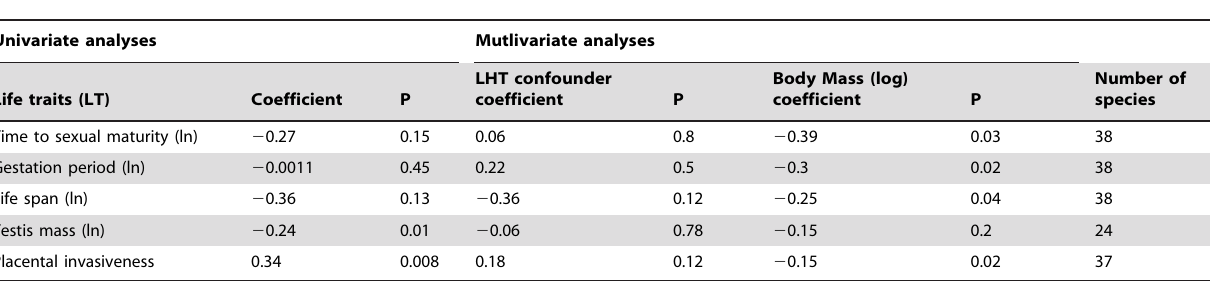
Table 1. Phylogenetically corrected correlations of number of ERVs per genome acquired over the last 10 my (log) against life history traits (LHT)